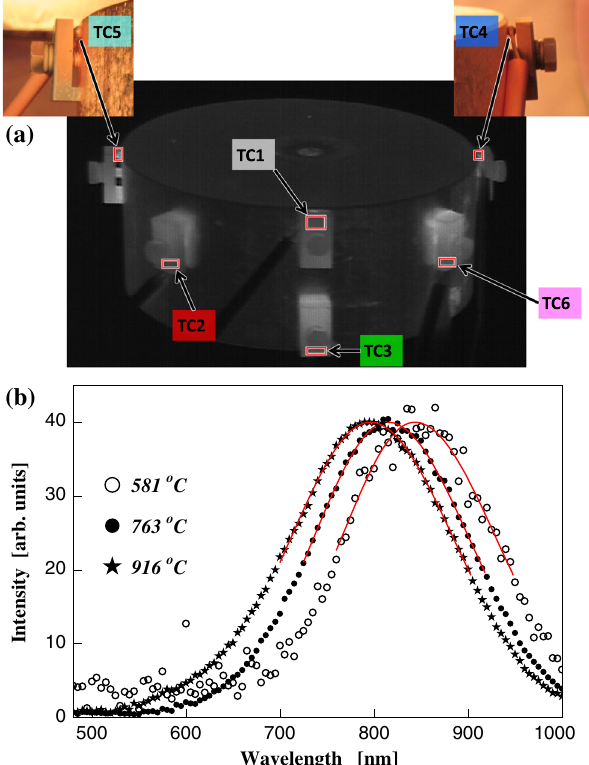
FIG. 13. Measurement of the thermal radiation. (a) Image of the copper cylinder taken by the hyperspectral camera at 800 nm at a temperature of approximately 930 °C. The red rectangles indicate the 2D regions in which spectrum measurements were obtained for the six thermocouples (TC1 – TC6). (b) Observed thermal radiation spectra from TC4 at temperatures of 581 °C (open circles), 763 °C (closed circles), and 916 °C (stars) after applying the pixel sensitivity and wavelength calibrations, correction for the transmissivity of the viewing window of the EBW machine, and background subtraction. The red curves show the results of fitting with an asymmetric Gaussian function, where the peak position of the resultant function is equivalent to λ p . The measured spectra are scaled so that the heights of the resultant functions are